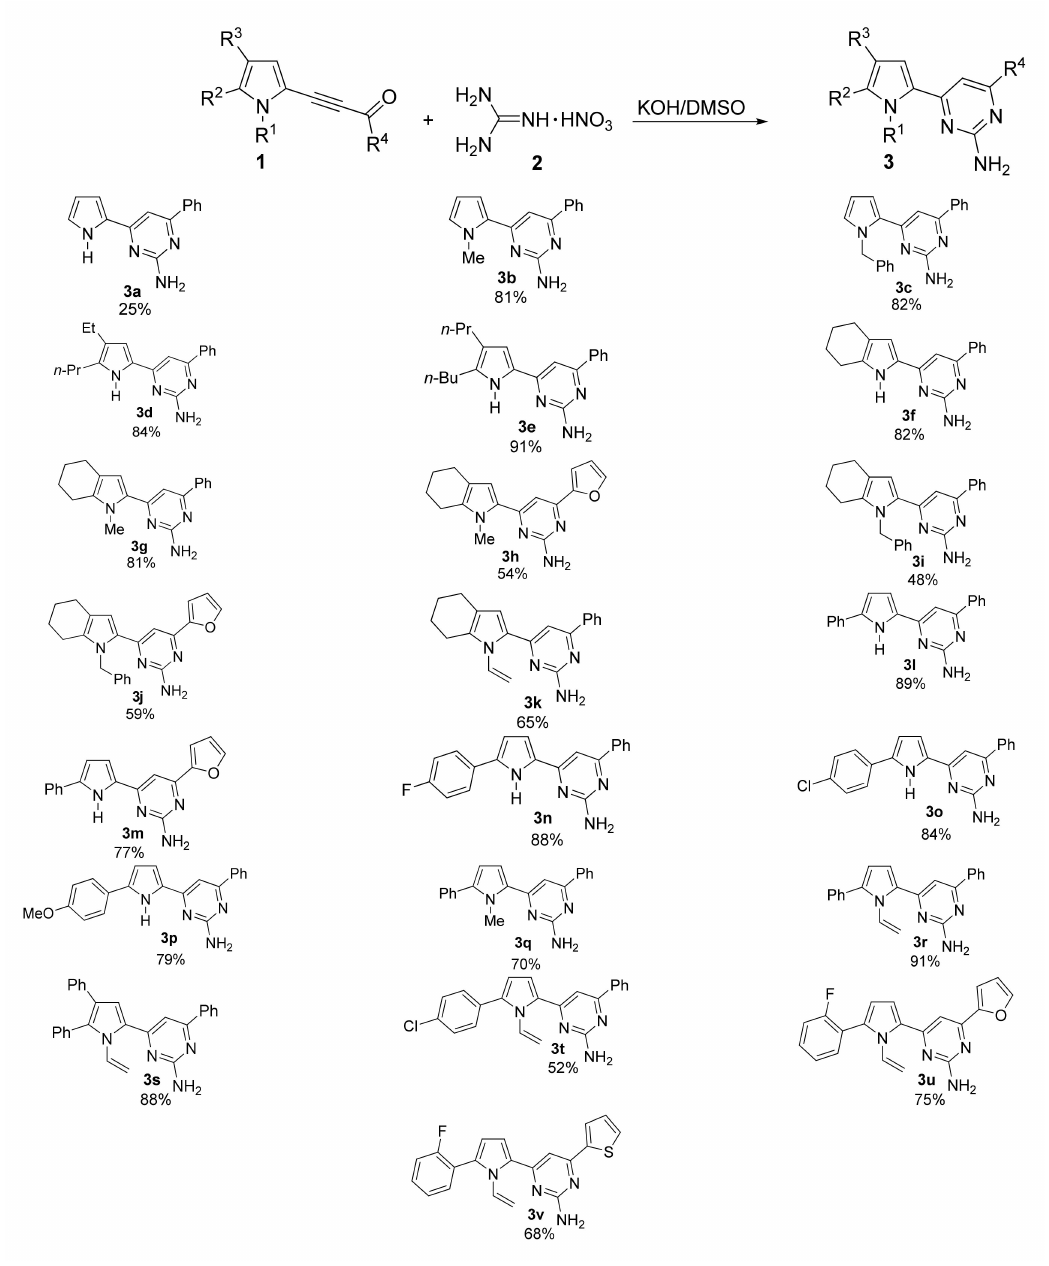
Figure 1. Synthesis of pyrrole–aminopyrimidine ensembles 3a – v from 2-acylethynylpyrroles 1a – v and guanidine nitrate. Reagents and conditions: (i) guanidine nitrate (0.40 mmol), KOH · 0.5H 2 O (0.60 mmol), DMSO (8 mL), 110–115 ◦ C, 0.5 h; (ii) 2-acylethynylpyrrole (0.40 mmol), 110–115 ◦ C, 4 h.